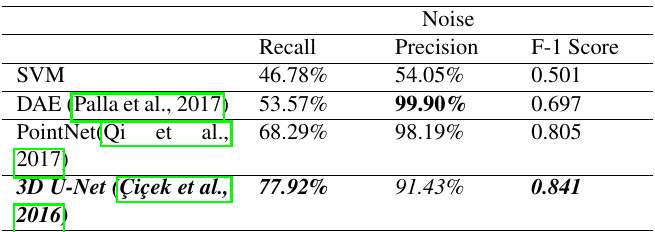
Table 1: Comparison of 3D U-Net for noise filtering with SVM, Denoising Autoencoder, and PointNet over recall, precision and F1-Score. Noise (w/o aug.) Noise (aug.)